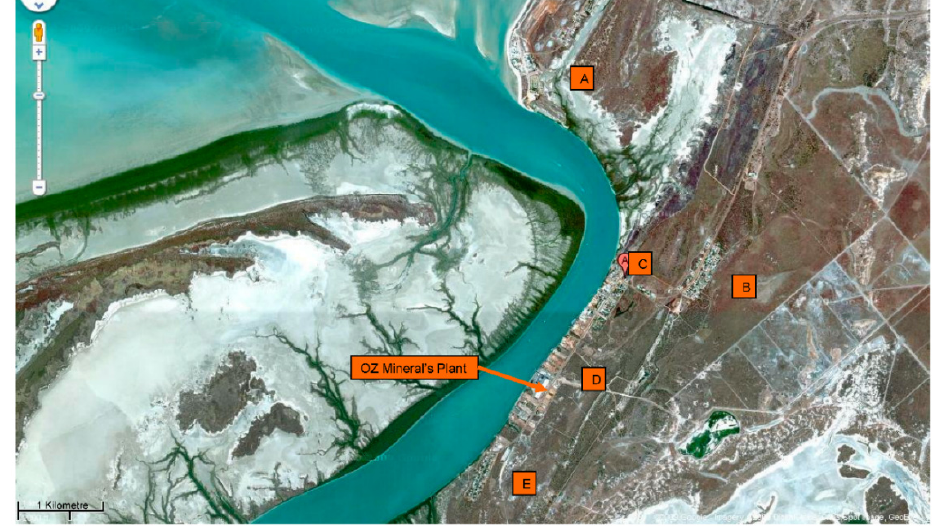
Figure 2. Map of Karumba Area showing OZ Mineral’s Mineral Processing and Export Facility and the localities of Karumba Point ( A ); Henry Street Area ( B ); Town Centre ( C ); Yappar Street Area ( D ) and Highbanks ( E ) (Source: Google Maps 2015).